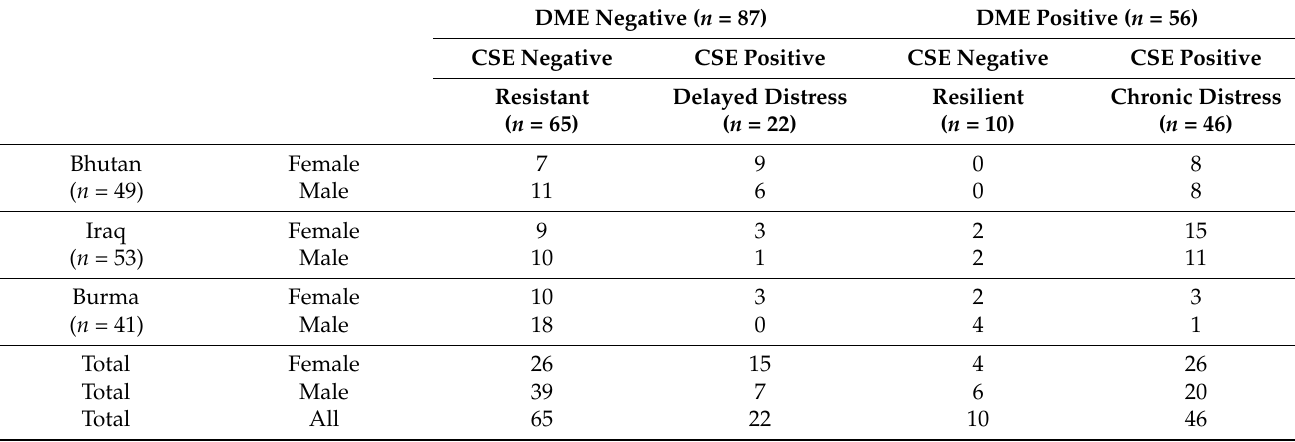
Table 1. RHS-15 case status (Positive = above RHS-15 cutscore; Negative = below RHS-15 cutscore) by country at DME (T1) and CSE (T2).